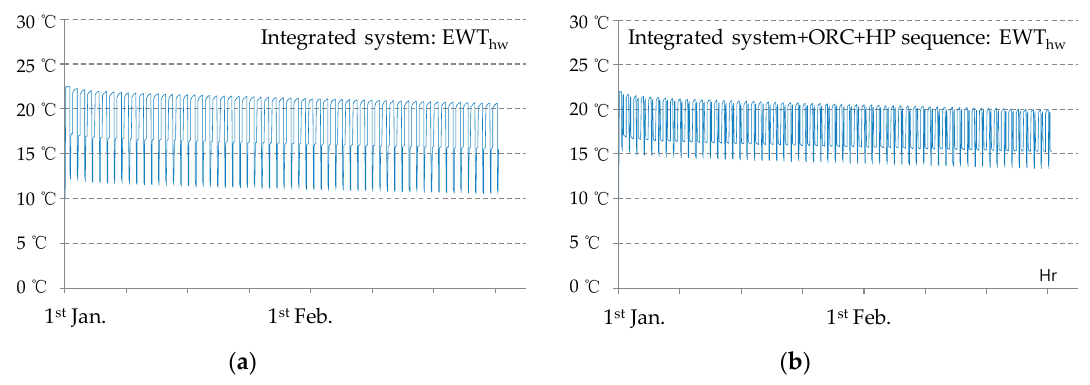
Figure 9. ( a ) EWT hw of the integrated system; ( b ) that with OARC in sequential operation during January and February.